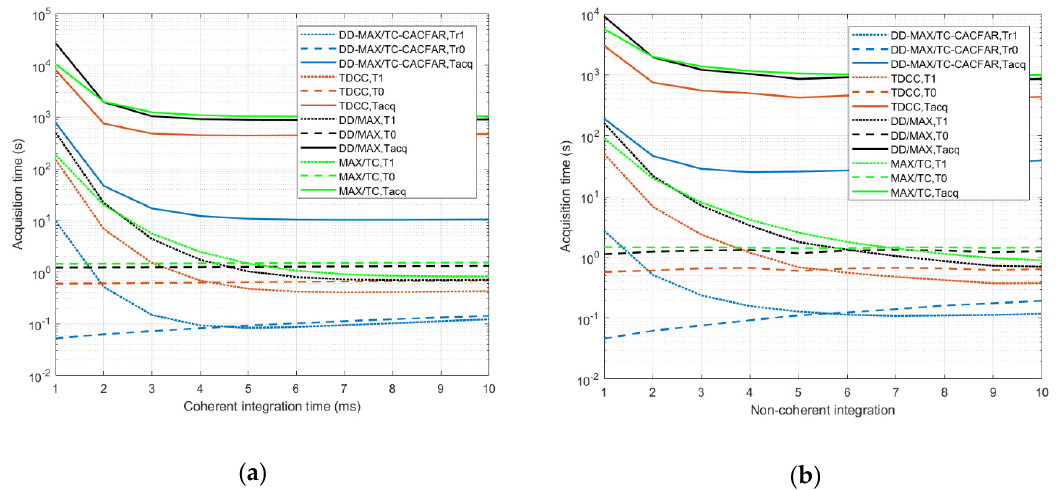
Figure 18. ( a ) Acquisition time versus CTIT (P fa = 0.001, SNR = − 36 dB, N nc = 2); ( b ) acquisition time versus NCT (P fa = 0.001, SNR = − 36 dB, CIT = 2 ms).